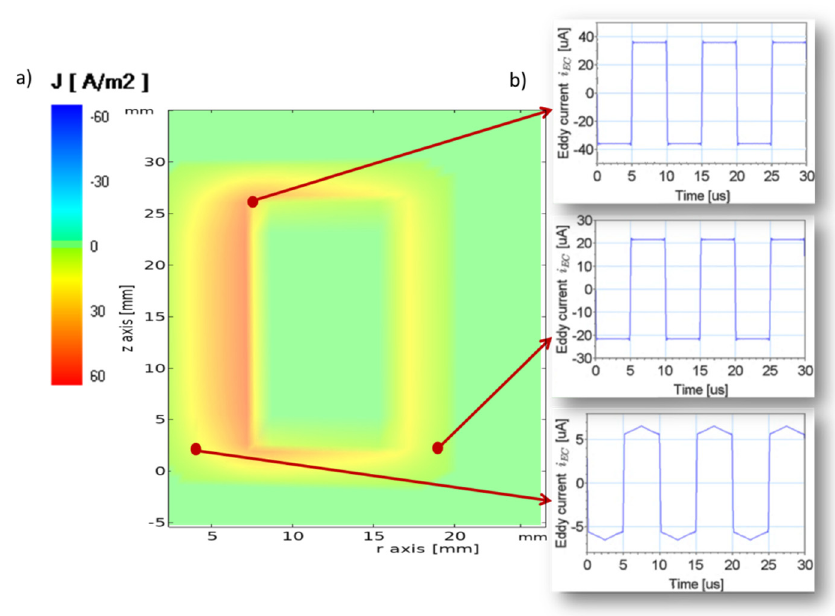
Figure 17. Distribution of the eddy current density in the ferrite core for time t = 9 us ( a ) and the waveforms of the eddy currents for three selected points of ferrite core ( b ) for a frequency of 100 kHz.